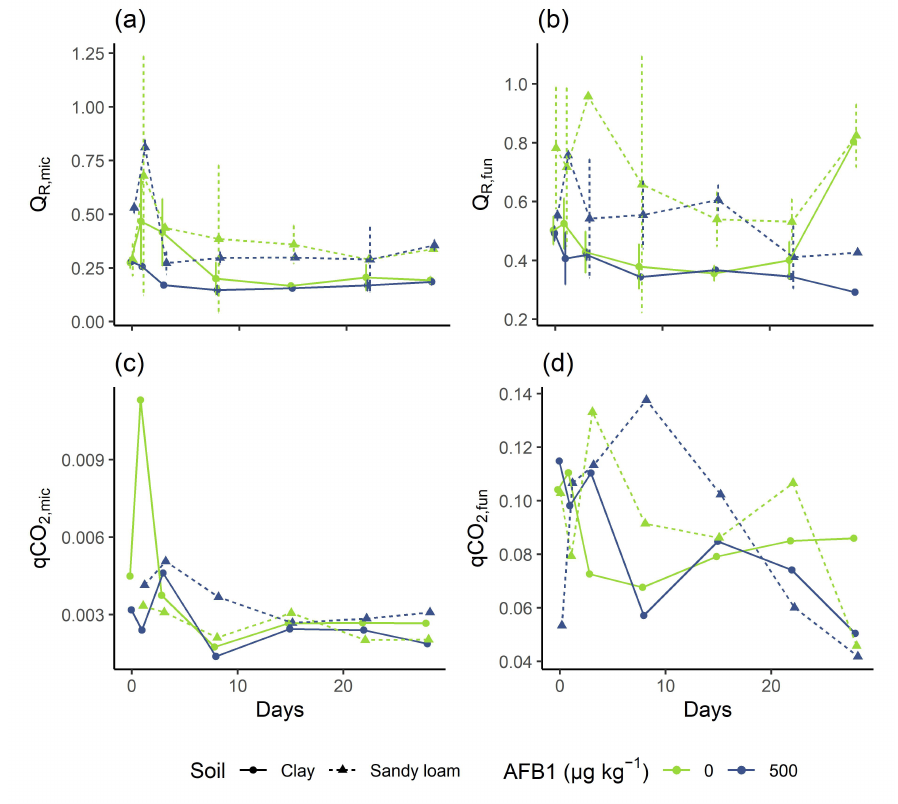
Figure 6. Ecophysiological ratios for AFB1-exposed (500 µg kg −1 ) and control soils as a function of incubation time. Microbial basal-to-substrate induced respiration Q R,mic ( a ), fungal basal-to-substrate induced respiration Q R,fun ( b ), microbial metabolic quotient qCO 2,mic ( c ), and fungal metabolic quotient qCO 2,fun ( d